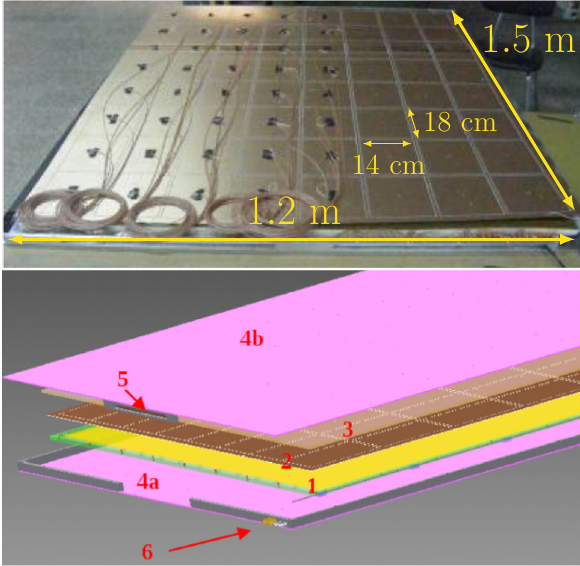
Fig. 2 Photo and scheme of the RPC detector. Top: RPC with visi- ble cabled pad plane showing the detector spacial resolution. Bottom: scheme of the RPC box (1), readout plane (2), I 2 C sensors layer (3), aluminium case base, cover and junction (4a, 4b, 5), and breakthroughs for gas and high-voltage (6)